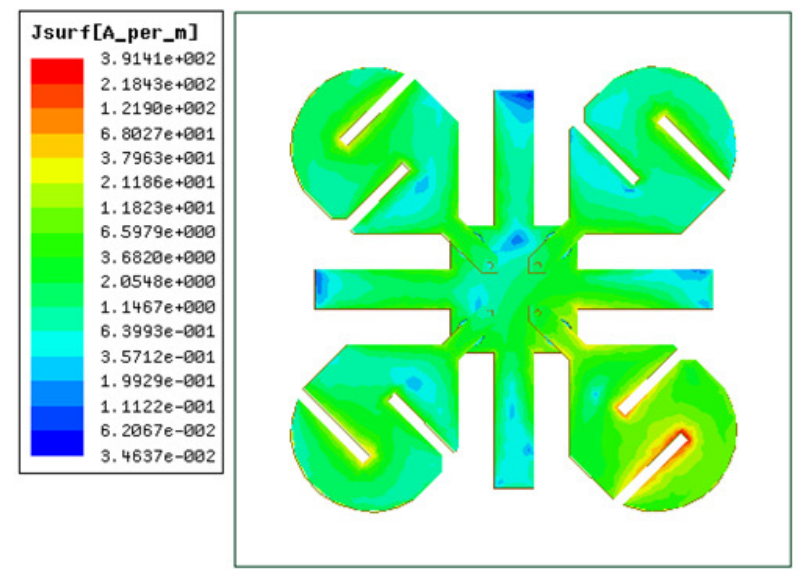
Figure 5. Surface current distribution on the MIMO antenna system when Ant-1 is